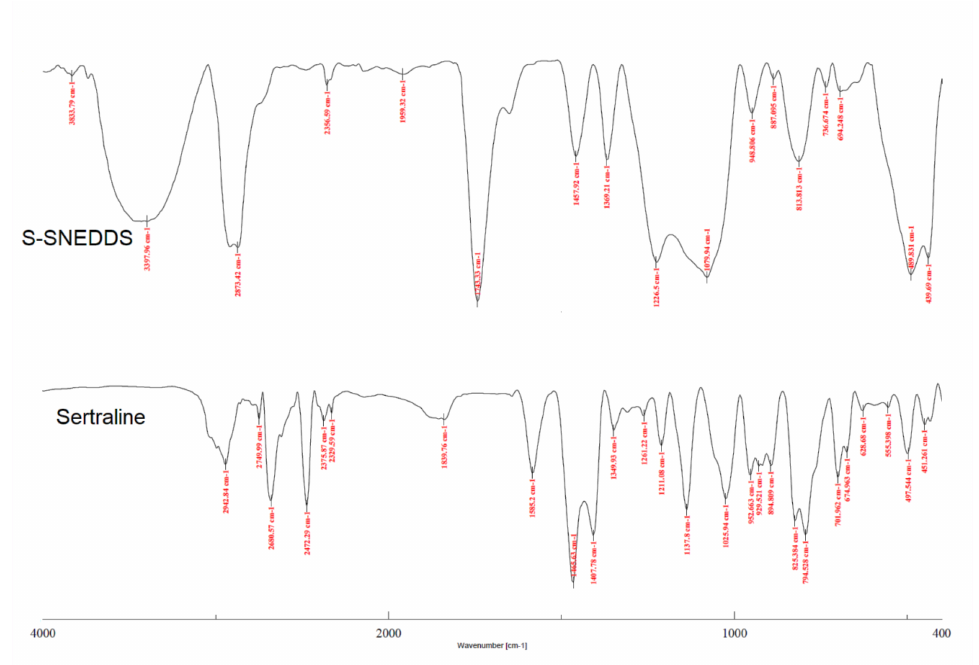
Figure 12. Fourier transform infrared spectroscopy of sertraline and prepared solid self- nanoemulsifying drug delivery system (S-SNEDDS).